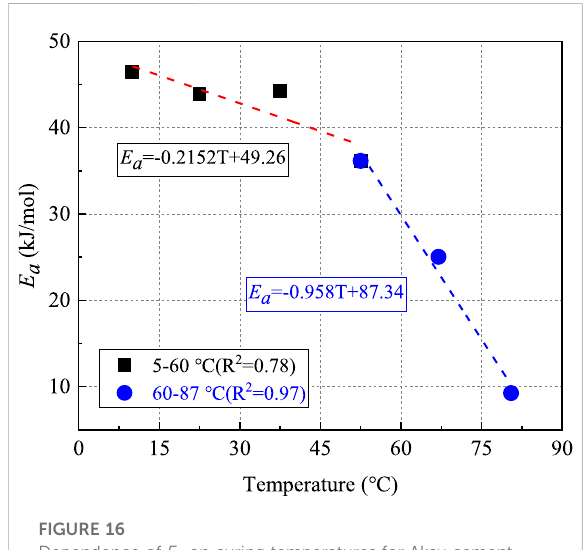
FIGURE 16 Dependence of E a on curing temperatures for Aksu cement